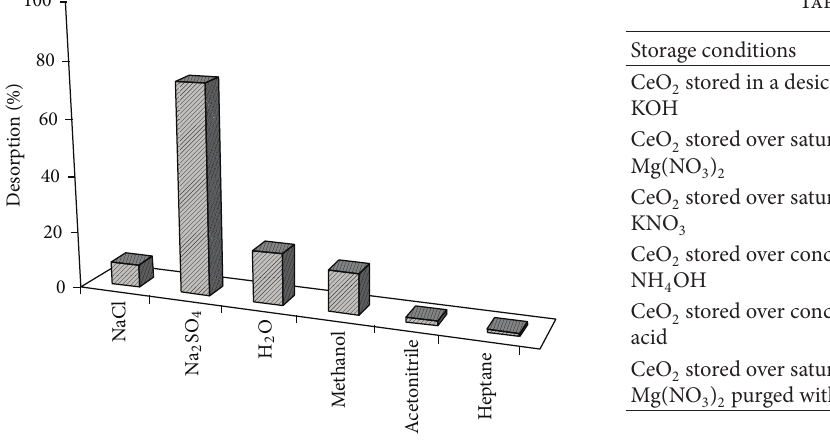
Figure 8: Desorption of AO7 from CeO 2 with various leaching agents. 0.2 g of the loaded sorbent leached with 20 mL of the respective agent, concentration of NaCl, and Na 2 SO 4 0.1mmol/L.